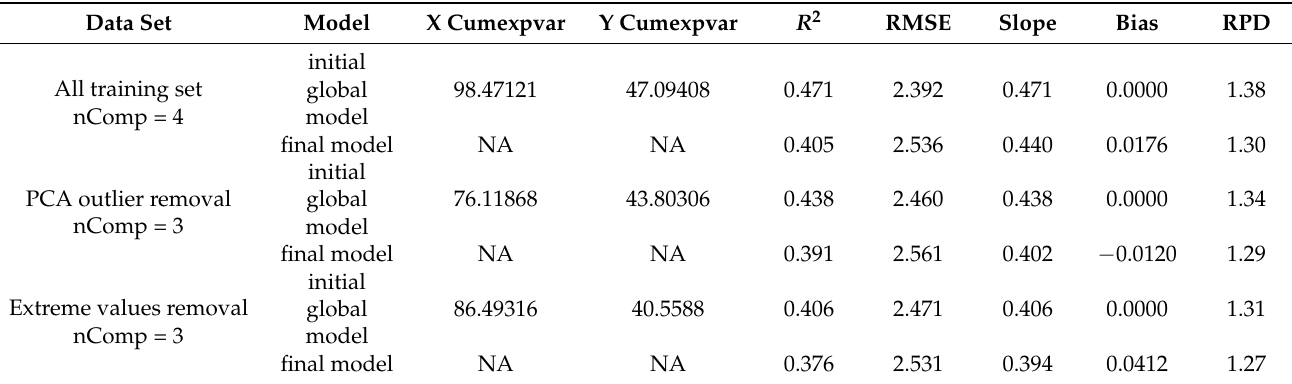
Table 3. iPLS models for the “hardness”